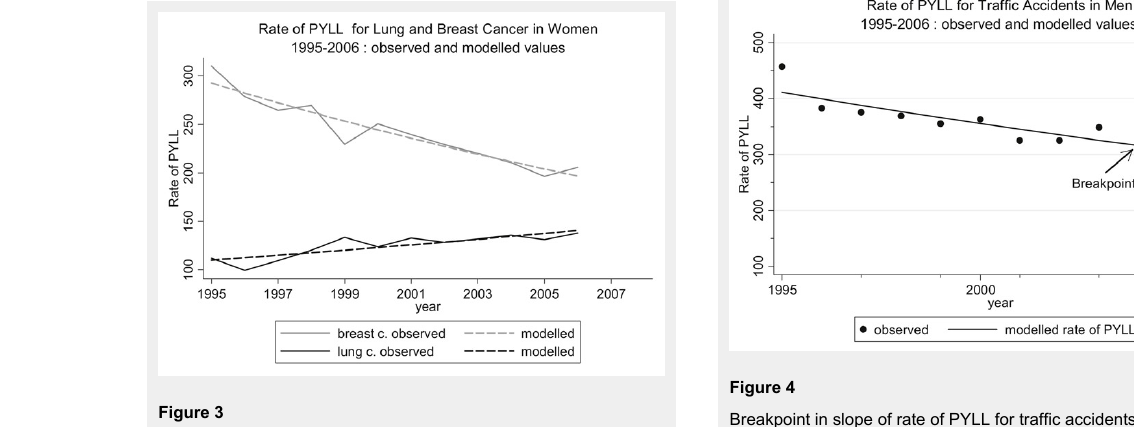
Evolution of rate of PYLL for lung and breast cancer in women from 1995 to 2006